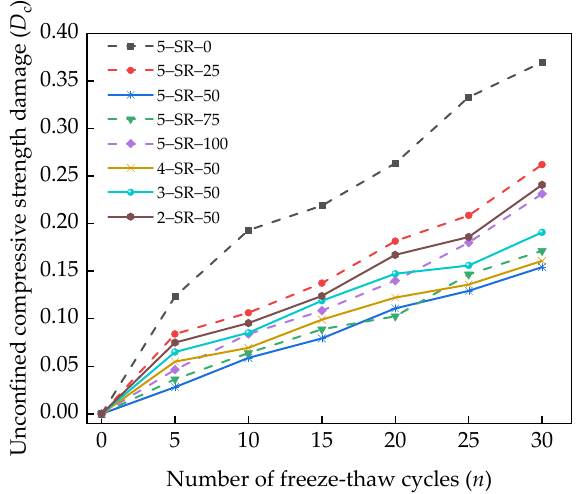
Figure 15. Relationship between unconfined compressive strength damage and freeze–thaw cycles.